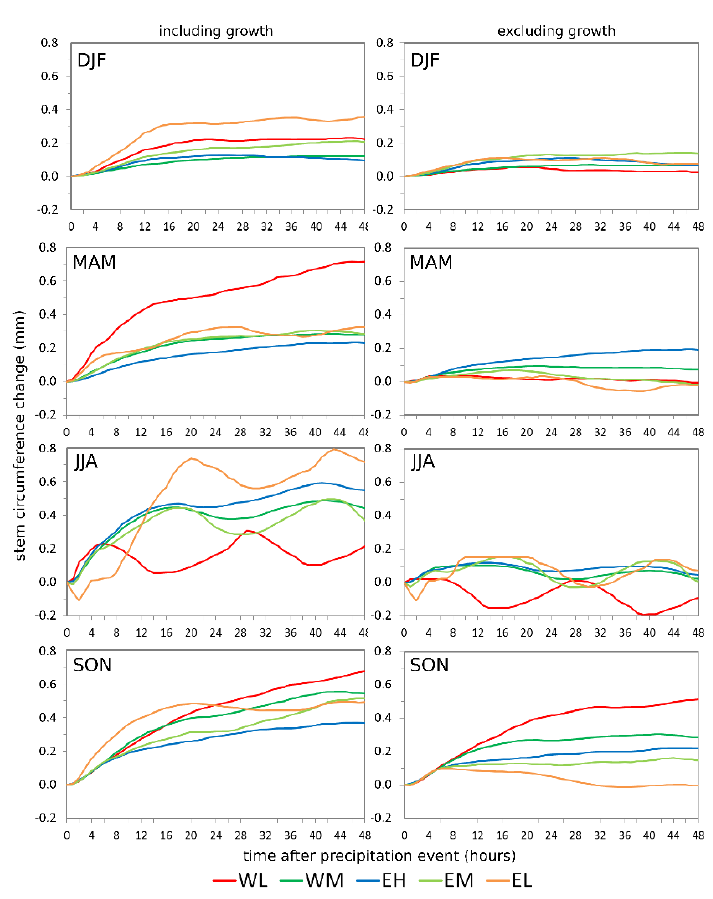
Figure 5. Mean stem circumference changes after precipitation events during different seasons, including ( left column ) and excluding ( right column ) tree growth. Precipitation events are extracted from the time period May 2017 to April 2019. Site codes refer to the east (E) and west (W) sides of Corsica, L, M, and H stand for low-, middle-, and high-elevation sites, respectively. amount. Large amounts of precipitation are more common during winter than during summer (Table